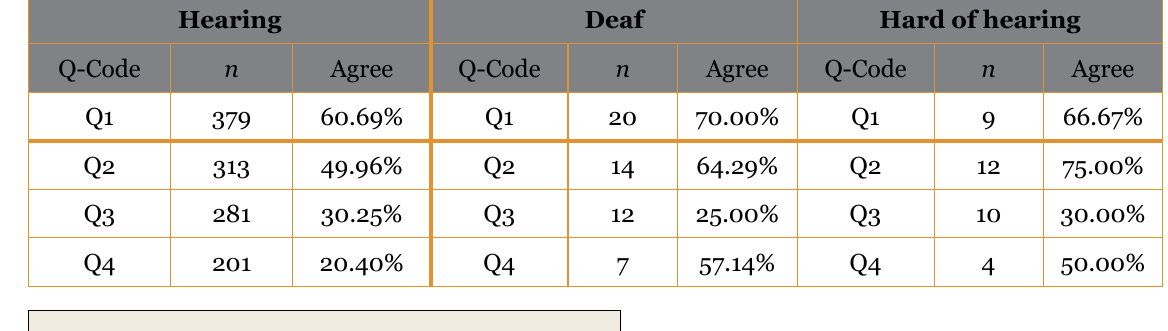
Figure 3. I interacted more with other students than I do in most courses.